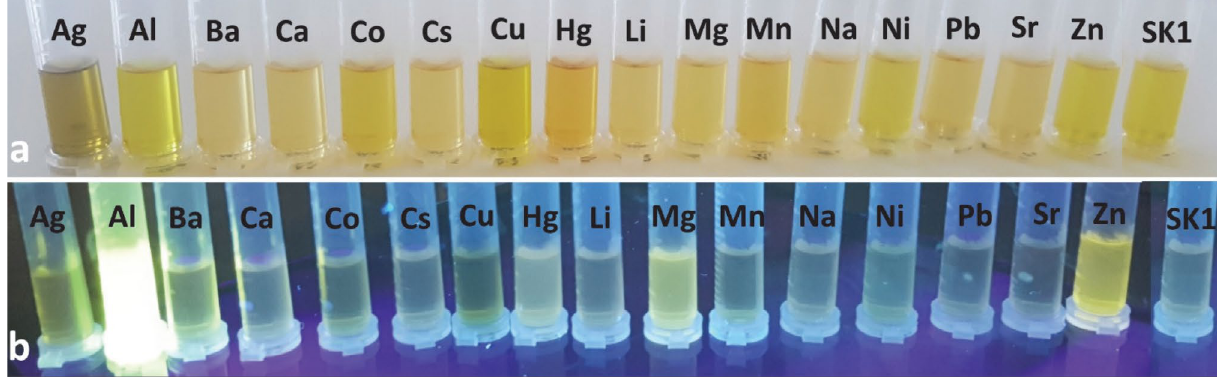
Fig. 3. Images showing the corresponding (a) visible color and (b) fluorescence color changes of SK-1 with and without metal cations (10 equiv. of Li + , Na + , Ag + , Ca 2+ , Ba 2+ , Co 2+ , Cs + , Cu 2+ , Mg 2+ , Hg 2+ , Mn 2+ , Pb 2+ , Ni 2+ , Sr 2+ , Zn 2+ and Al 3+ ) under day light and UV light.